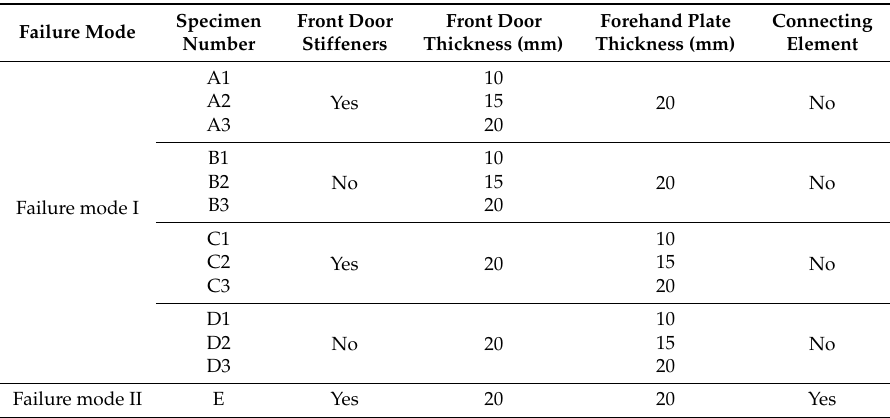
Figure 1. Schematic diagram of the refuge chamber model. Table 1. Design parameters used in the refuge chamber.